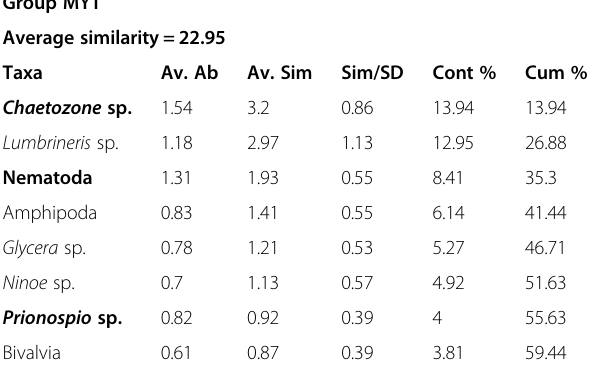
Table 7 Output of SIMPER analyses obtained from abundance species data. In bold the most representative taxa for similarity within each group (MYT, SAL, REF sites) Group MYT Average similarity =